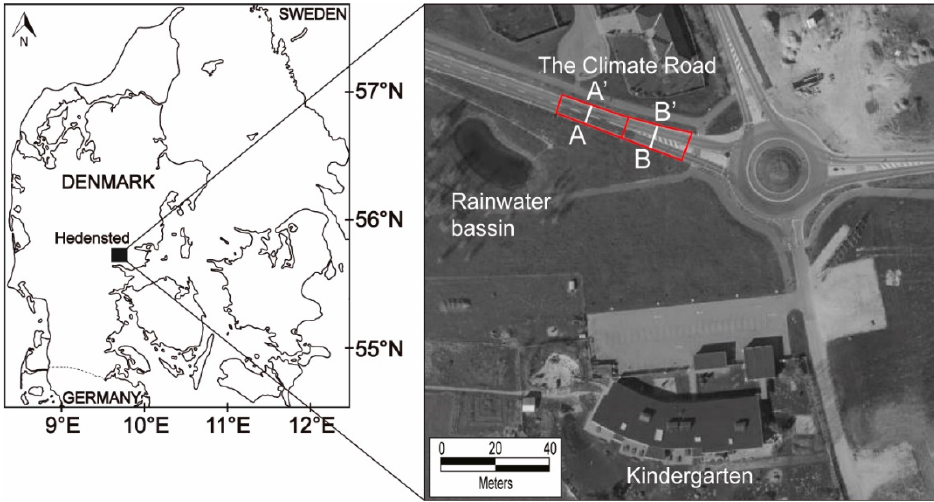
Figure 1. Overview of the road sections with traditional and permeable asphalt. A-A’ and B-B’ indicate transects of the sections with permeable and impermeable asphalt, respectively.